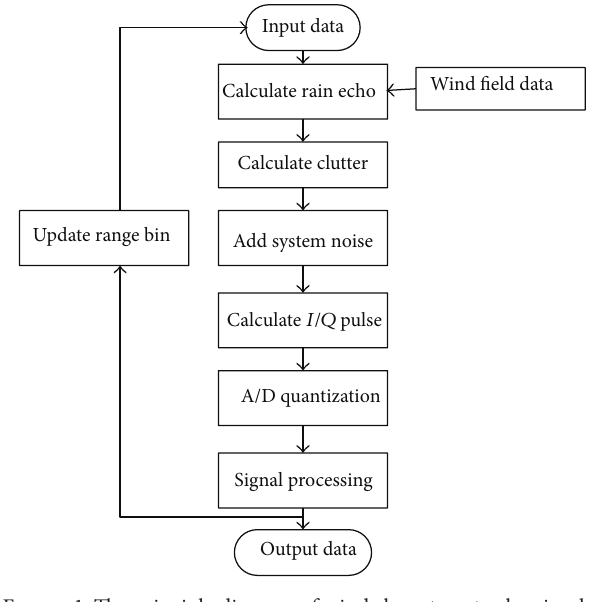
Figure 1: The principle diagram of wind shear target echo simula-